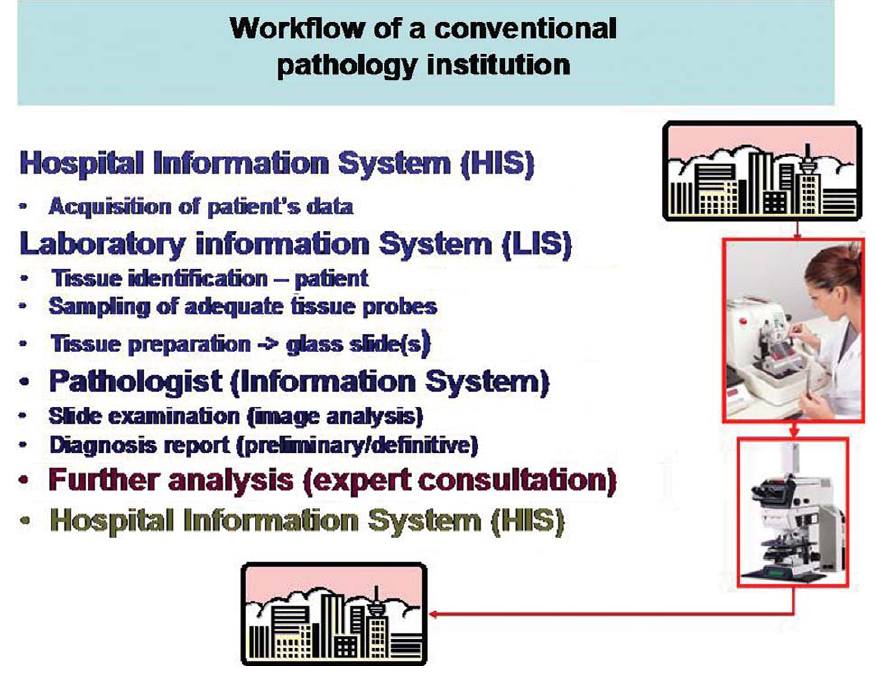
Fig. 1. Workflow of routine diagnostics in a conventional institute of